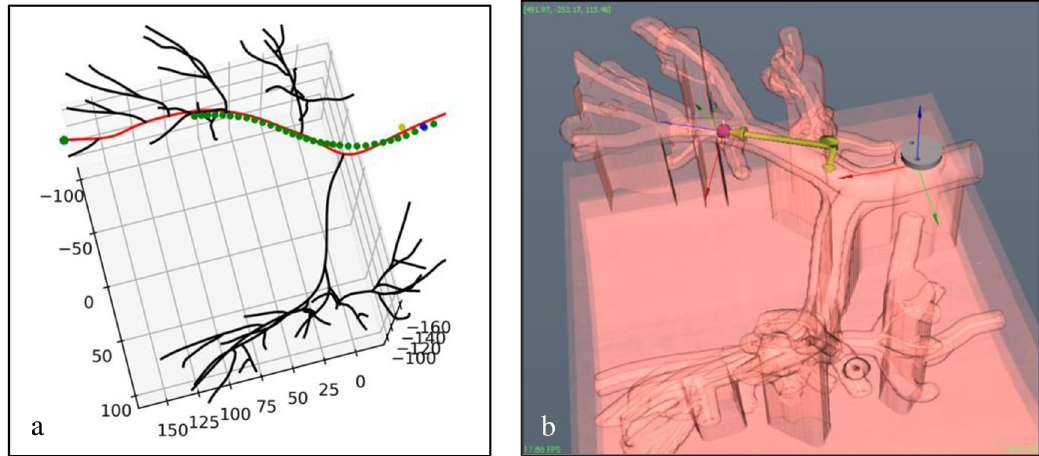
Fig 9. Output of the AIrShape software. a: software display of the shape-sensing catheter position (green dot line) in the correct lung airway (red line) and the remaining airways (black lines). b: the position of the FBG catheter’s tip is confirmed with the iMTECH platform (red circle). The reference marker (grey circle), initial entry point (green circle) and the coordinate system (green arrows) are also